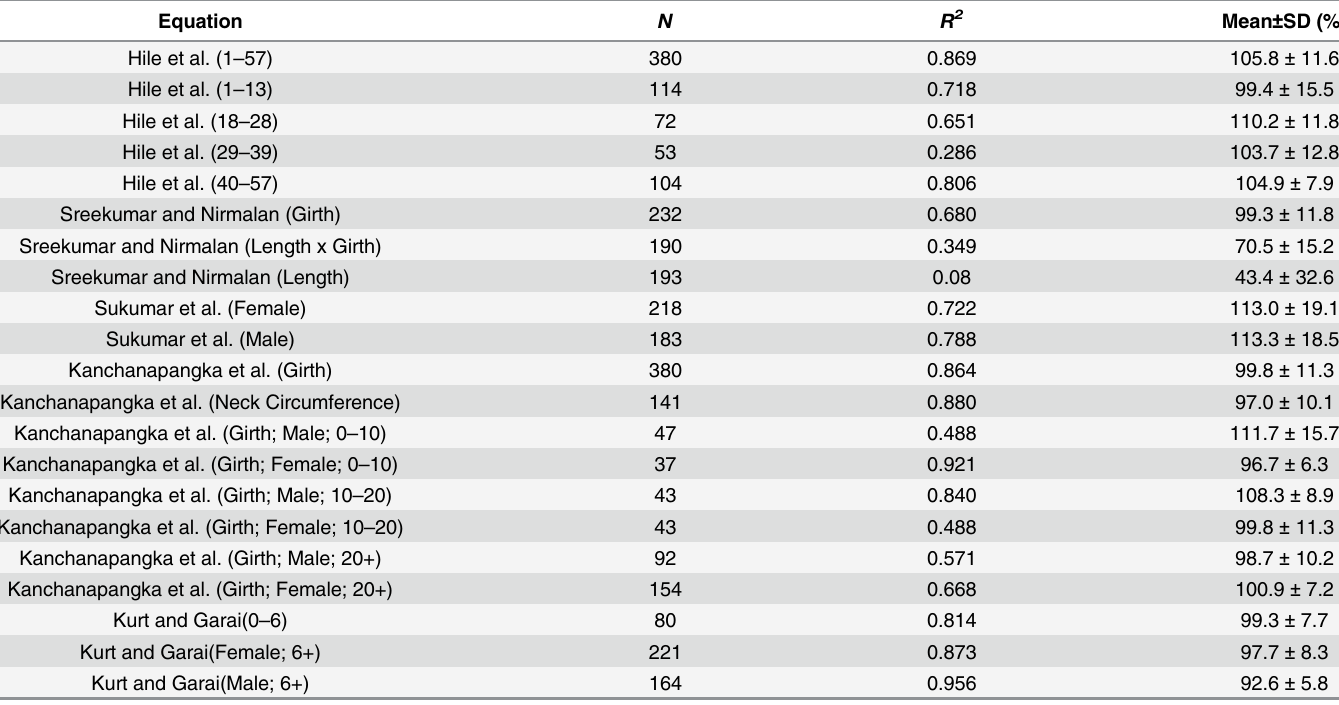
Table 2. Summary of the fit of equations from the literature to the Myanmar timber elephant dataset.